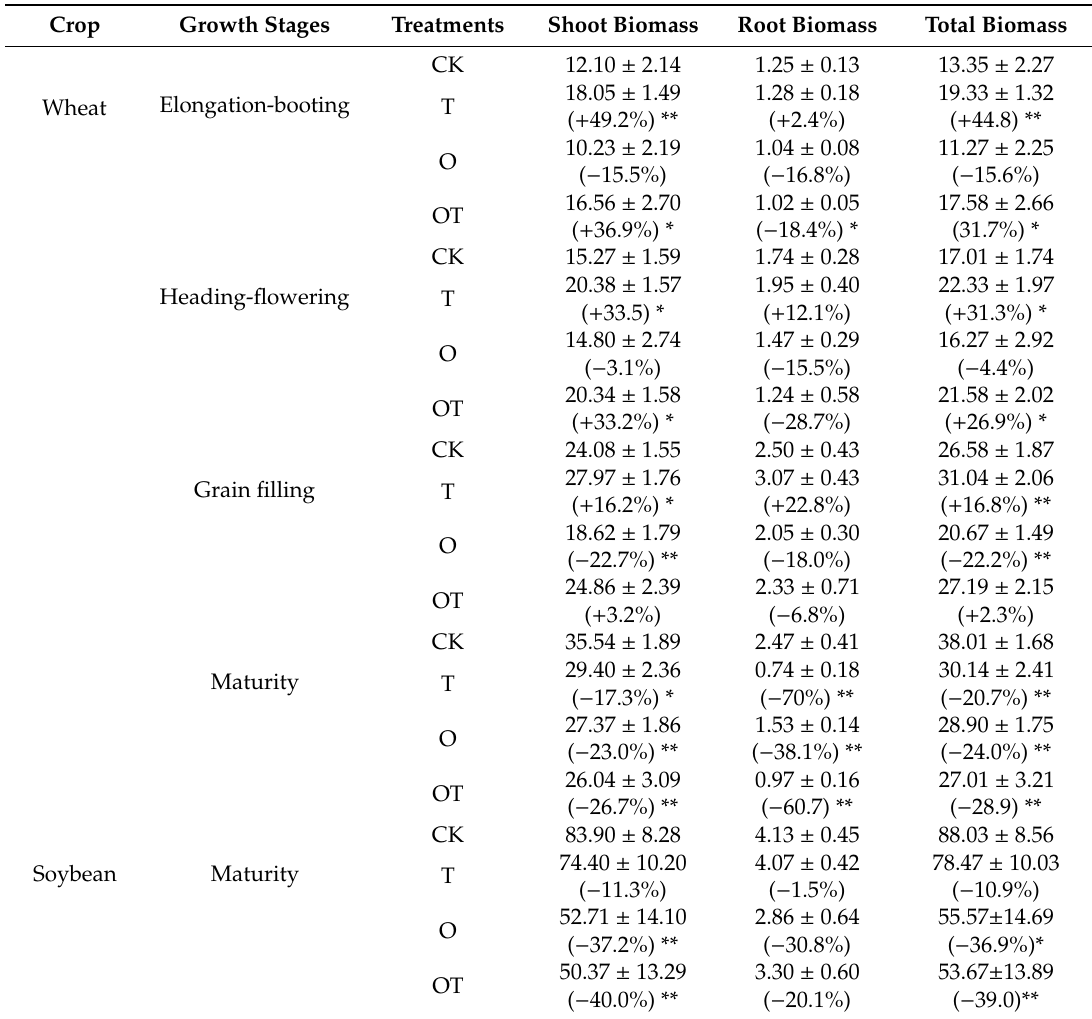
Table 4. E ff ect of warming and elevated O 3 concentration on biomass of wheat and soybean (grams per base